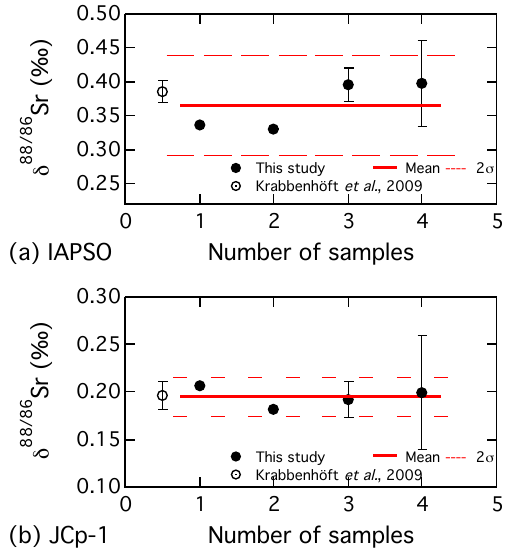
Figure 3. Stable Sr results for (a) seawater standard IAPSO and (b) inter-laboratory biogenic carbonate standards JCp-1.